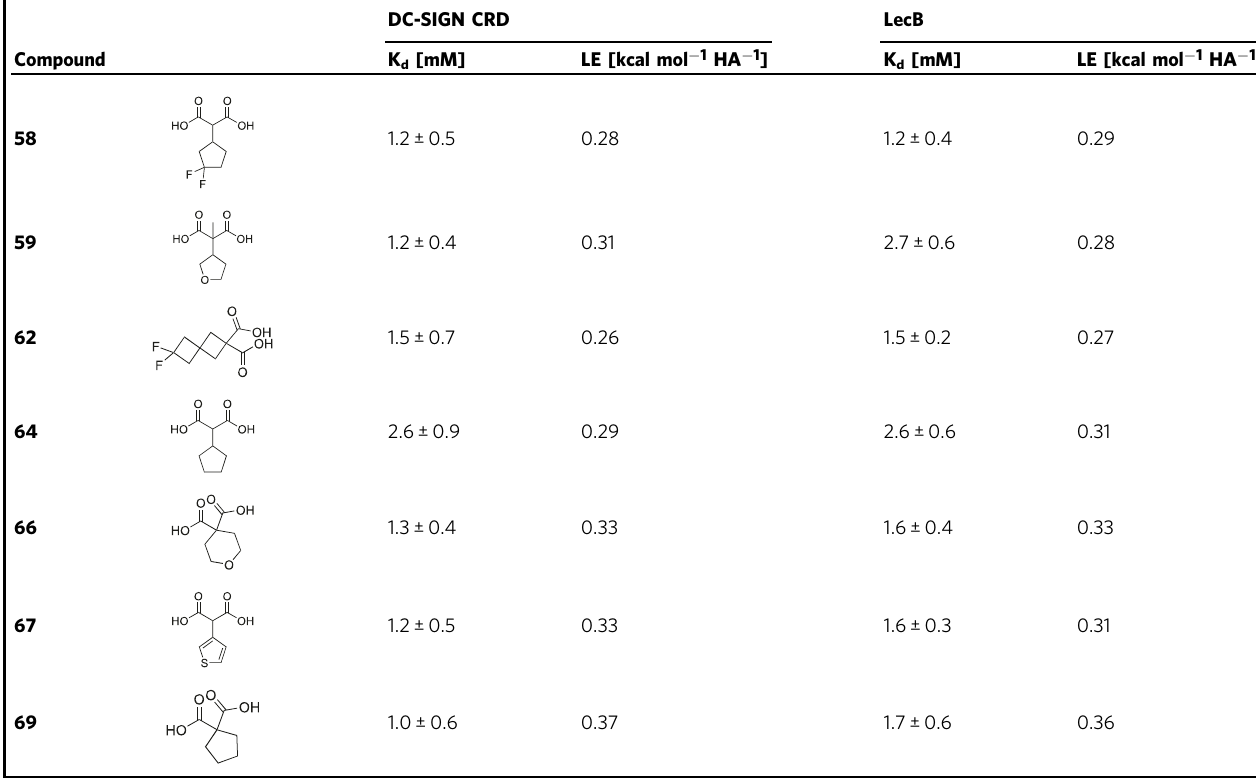
Table 2 Overview of malonate 58 analogs to target LecB and